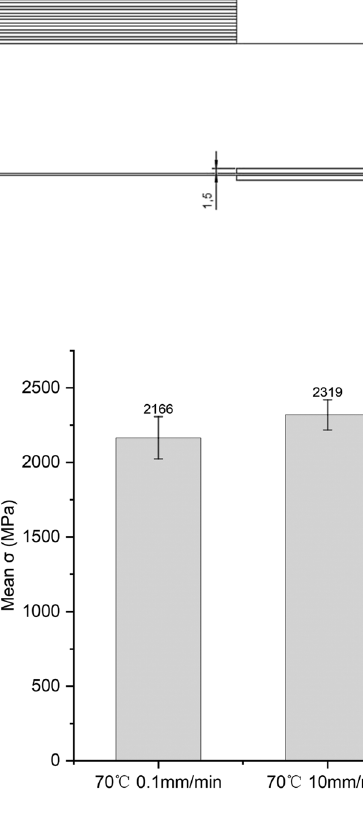
Figure 5: Strength comparison of di ff erent loading conditions.